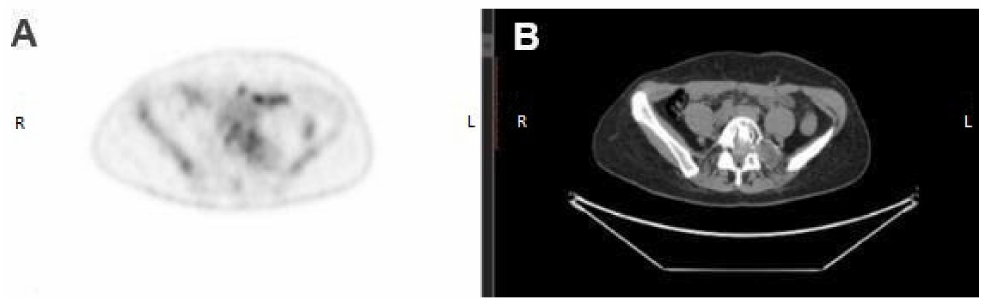
Figure 2. ( A ) PET image in the transverse plane, confirming the abnormal fluorodeoxyglucose uptake within the metastatic lesion localized in L5 vertebral body. ( B ) CT image at the same level showed a hypodense focus (previously unpublished, original photos).